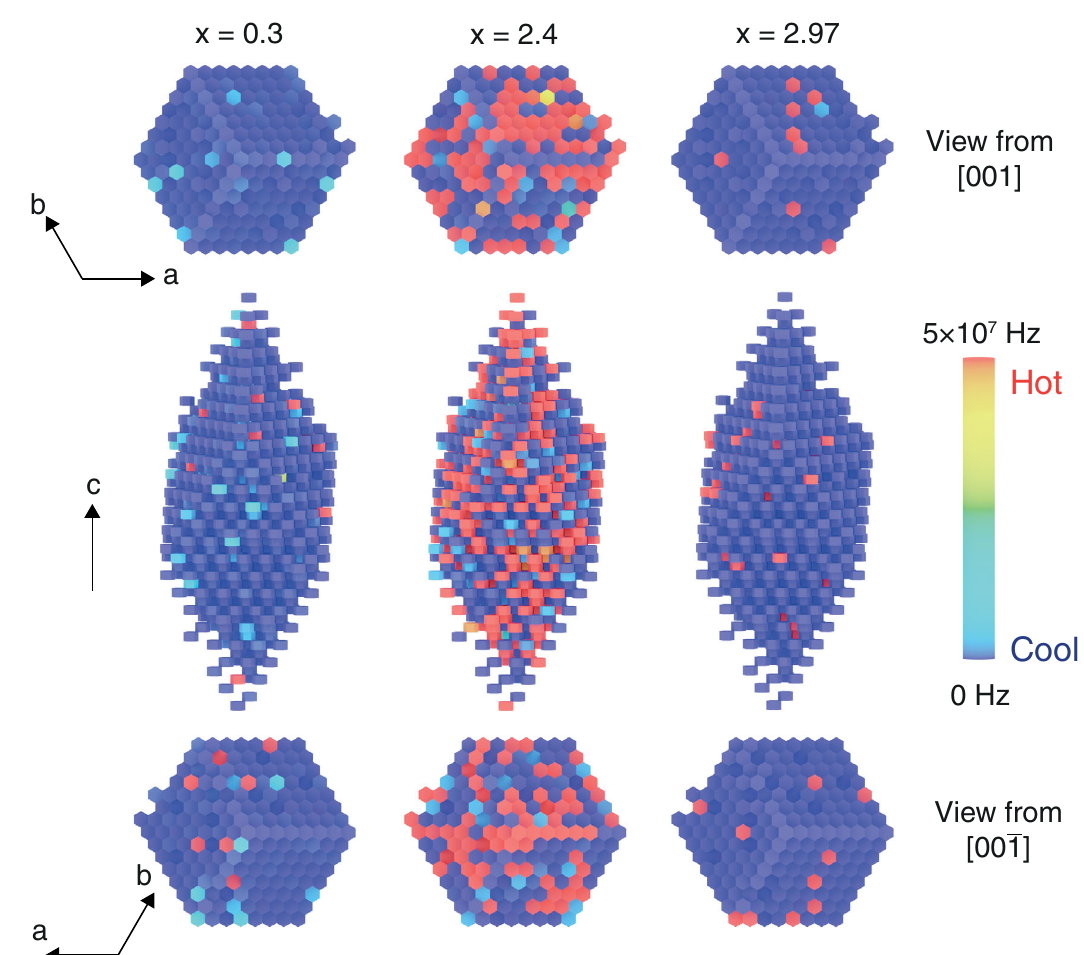
Fig. 5 | Sodium hopping frequencies in NASICON materials. Heatmap repre- sentation of the frequency (in Hz) of Na-ion migration from selected kMC simu- lationsupercells(8×8×8oftheprimitivecell,including1024migrationunits)atNa contents of x = 0.3, 2.4 and 2.97. The temperature in all panels is 573K. Each coloredhexagonalprismrepresentsamigrationunit,asexempli fi edinFig.1d.The